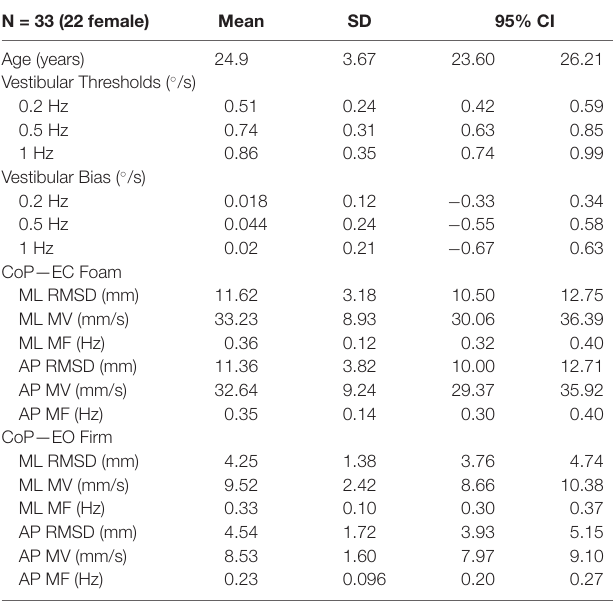
TABLE 1 | Demographic information of participants and summary statistics for variables of interest. N = 33 (22